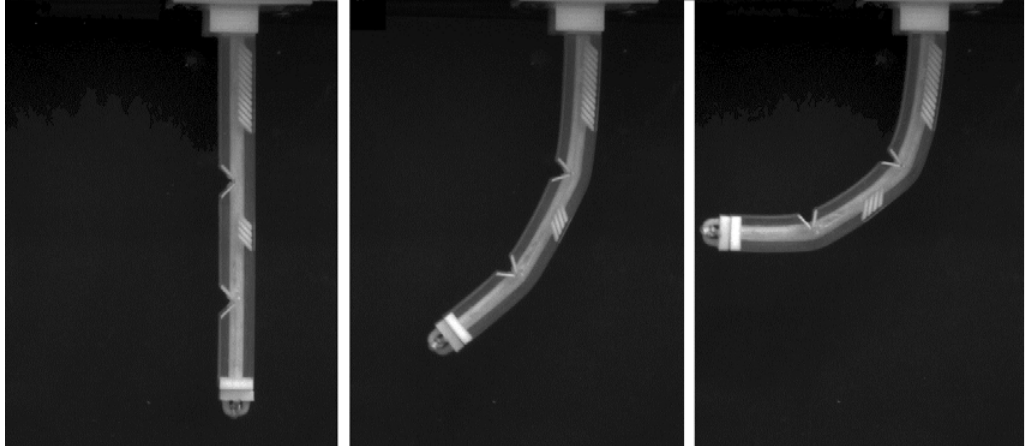
Figure 10. Force-retraction curves for the homogeneous TangoPlus actuator, the actuator with stiff scales, and the actuator with tubular concentric inserts around channel under additional 50 g weight on free end ( a ). Force-retraction curves for the actuator with tubular concentric inserts with different weights attached to the free end of the specimen ( b ).